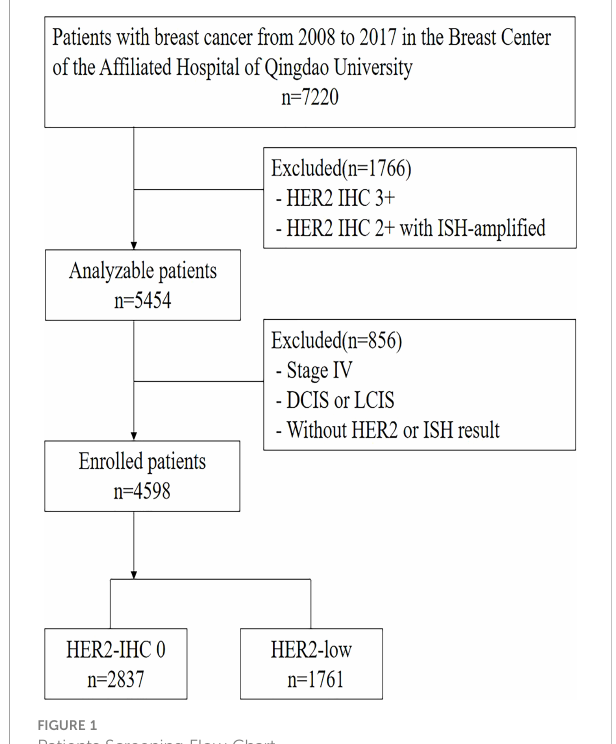
FIGURE 1 Patients Screening Flow